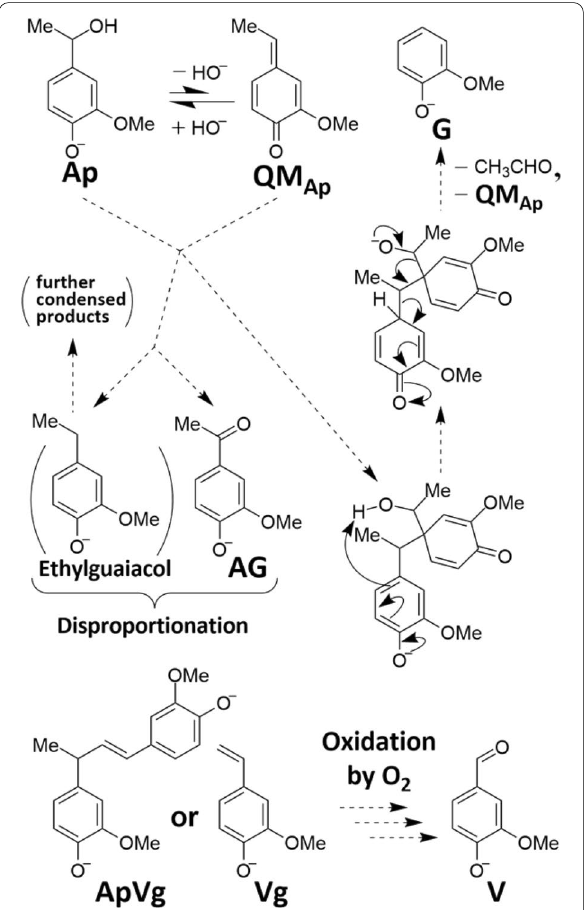
Fig. 8 Possible formation reactions of AG , G , and V in this